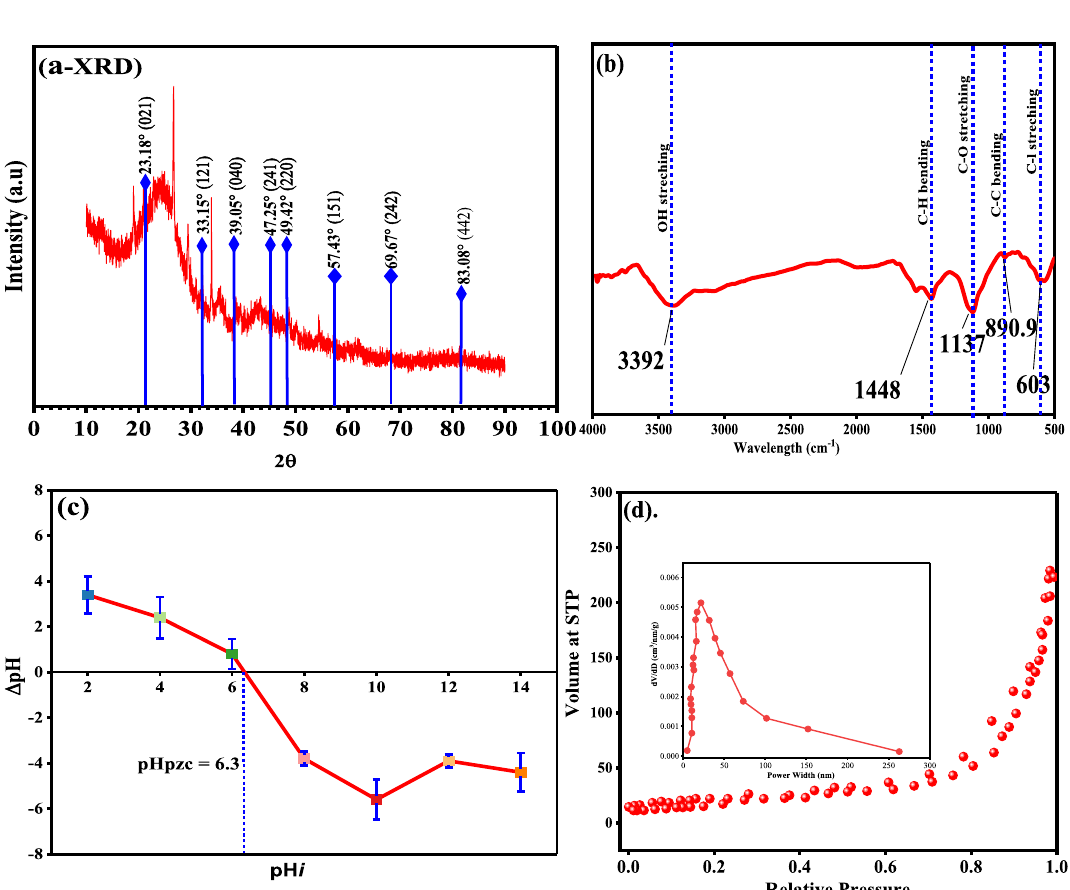
Fig. 3 a XRD pattern, b FTIR spectra, c surface pH of adsorbent ( d ) pore‑particle size